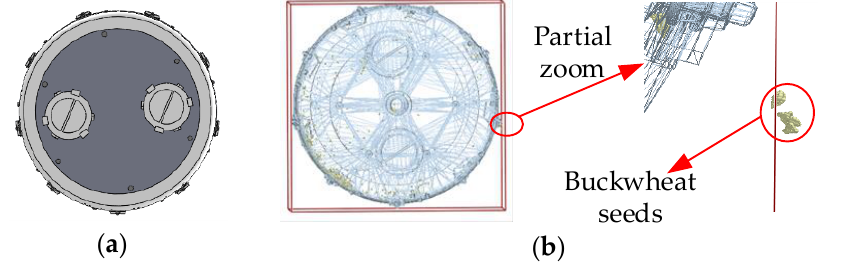
Figure 6. EDEM simulation model of seed metering device. ( a ) 3D model; ( b ) grid structure simulation model.